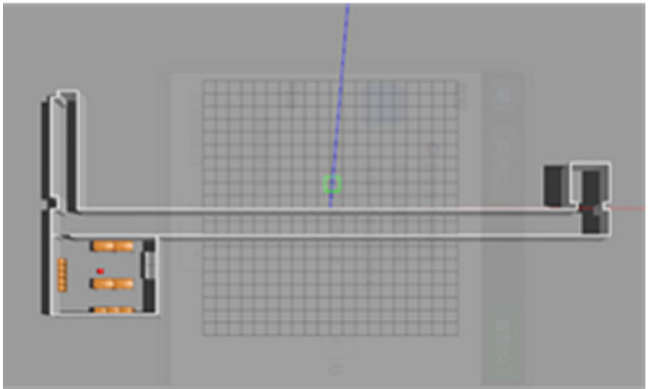
Figure 11. “Lab ‐ corridor” model. Figure 11. “Lab-corridor”